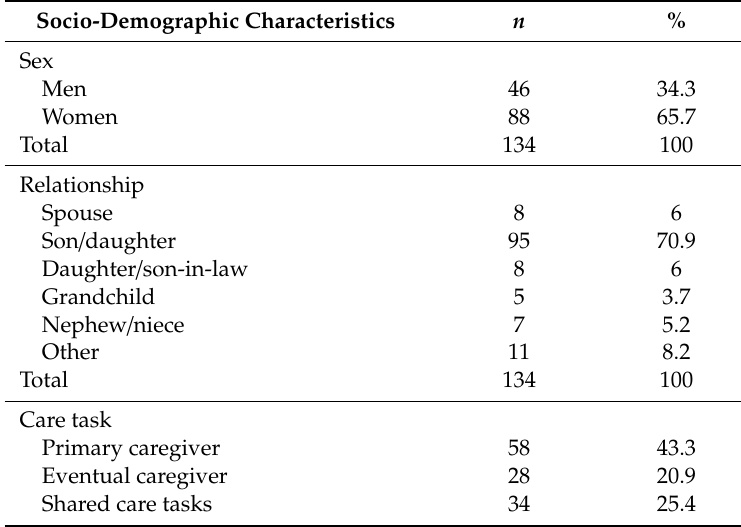
Table 1. Socio-demographic characteristics of the family members participating in the